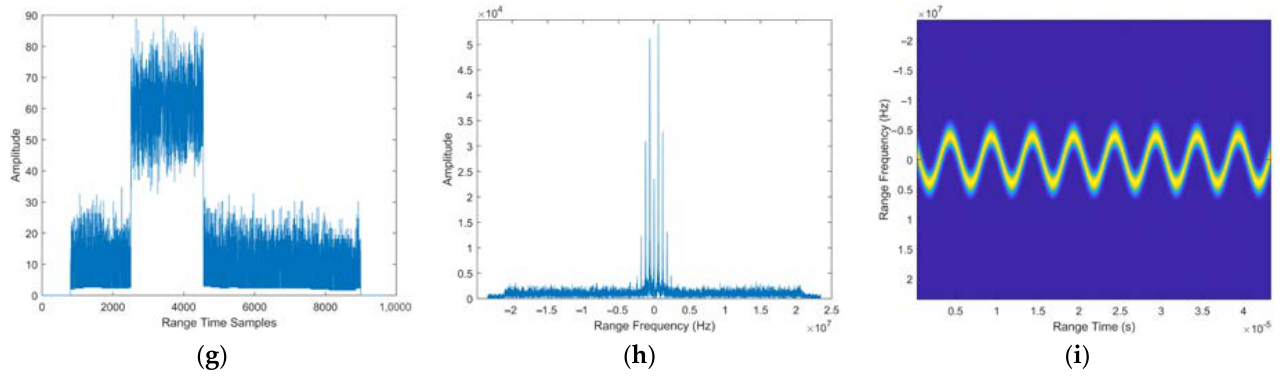
Figure 2. The RFI-contaminated SAR echoes in different domains. ( a ) The NBI-contaminated SAR echo in the time domain, ( b ) the NBI-contaminated SAR echo in the range-frequency domain, ( c ) the NBI-contaminated SAR echo in the time-frequency domain, ( d ) the LFM WBI-contaminated SAR echo in the time domain, ( e ) the LFM WBI-contaminated SAR echo in the range-frequency domain, ( f ) the LFM WBI-contaminated SAR echo in the time-frequency domain, ( g ) the SFM WBI-contaminated SAR echo in the time domain, ( h ) the SFM WBI-contaminated SAR echo in the range-frequency domain, ( i ) the SFM WBI-contaminated SAR echo in the time-frequency domain.